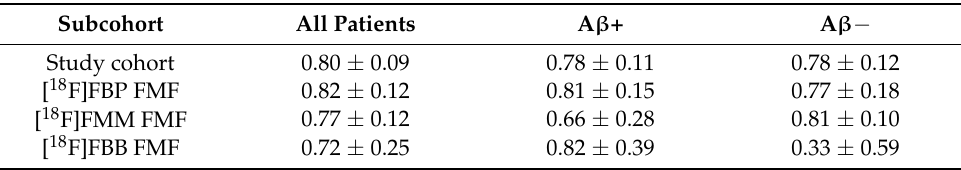
Table 5. Mean ± SD interpatient correlation coefficients of FMFs and [ 18 F]FDG PET of individual brain